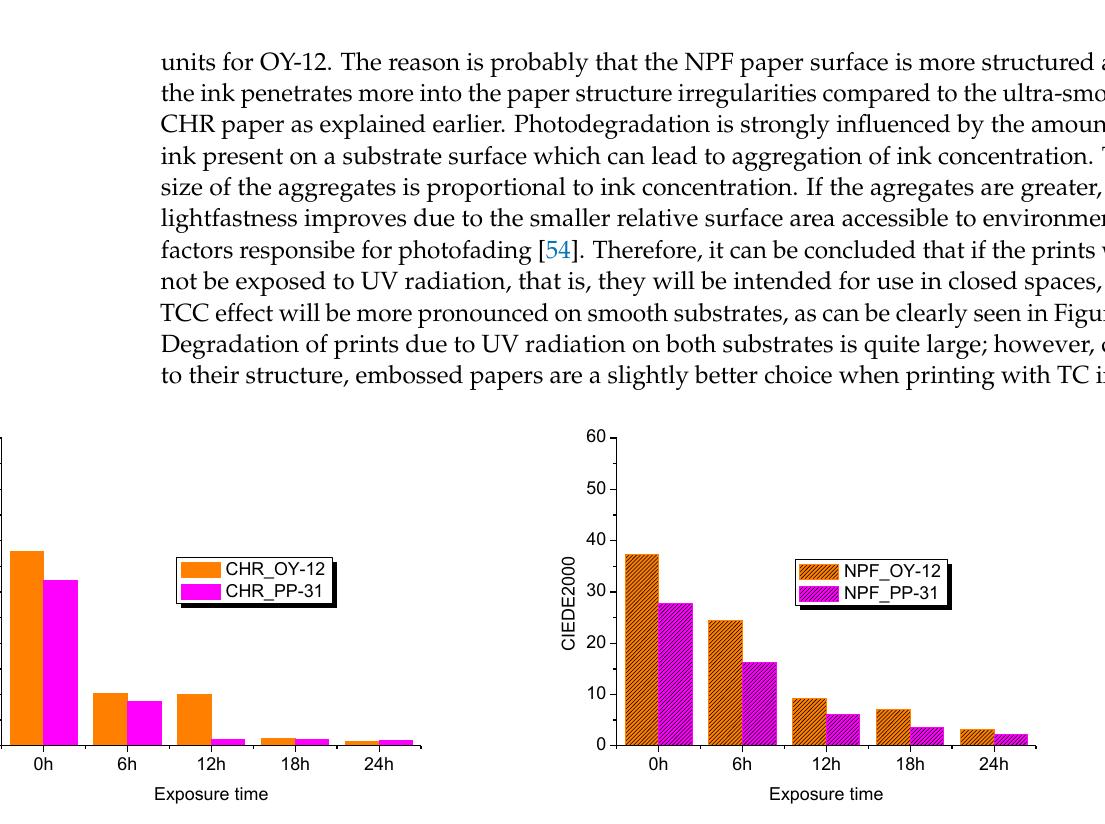
Figure 9. The total color contrast (TCC) between the two states for the OY-12 and PP-31 prints before and after 6, 12, 18, and 24 h exposure to UV radiation.